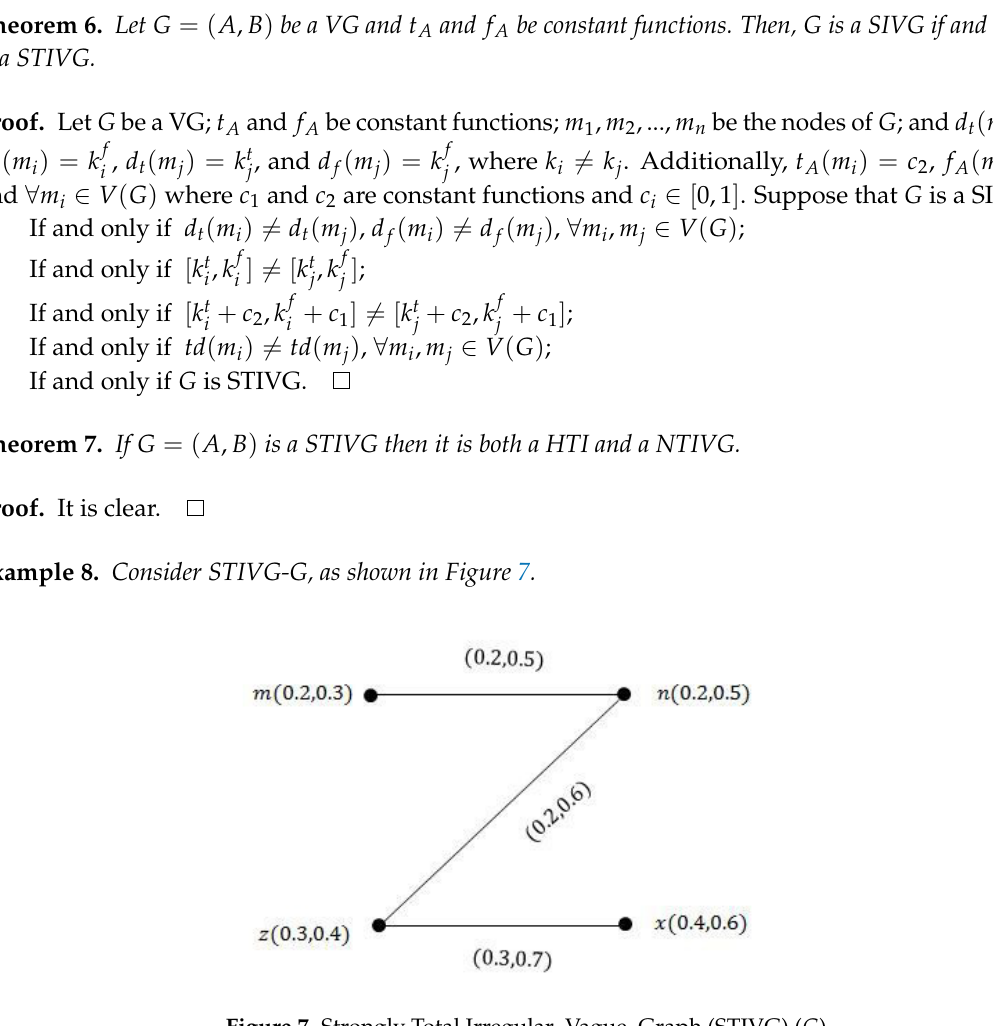
Figure 7. Strongly Total Irregular Vague Graph (STIVG) ( G